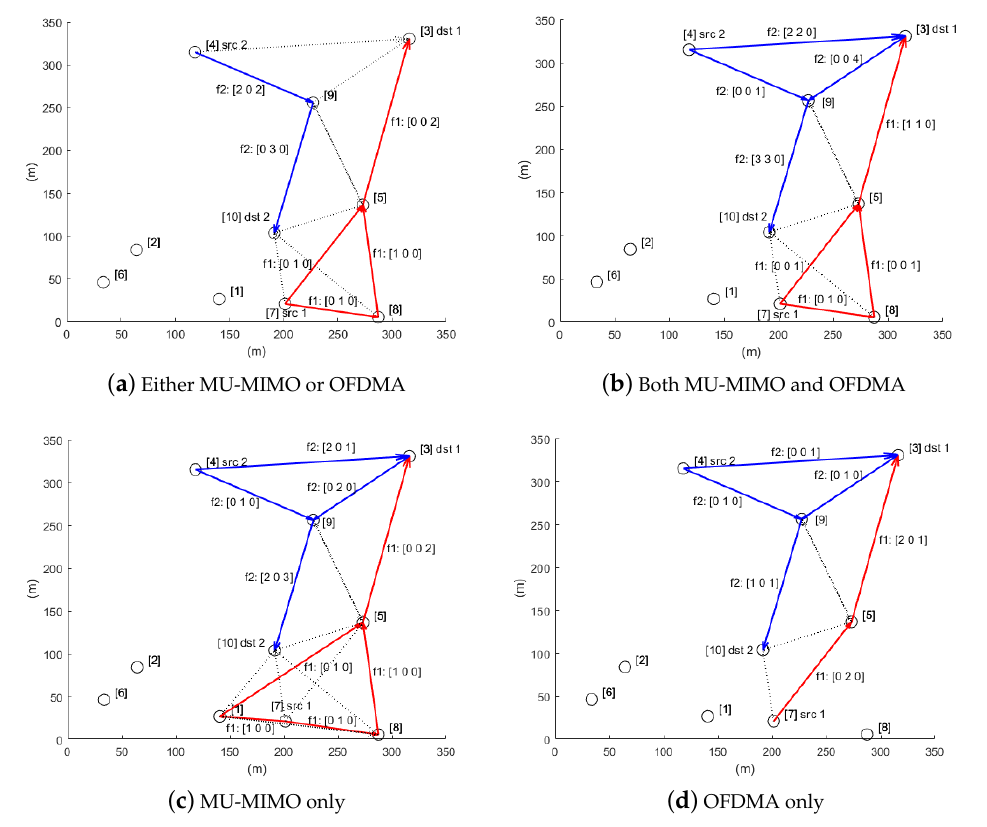
Figure 3. Resource allocation results for sum-rate maximization. The joint use of MU-MIMO and OFDMA ( b ) creates more multi-user transmissions, resulting in a higher